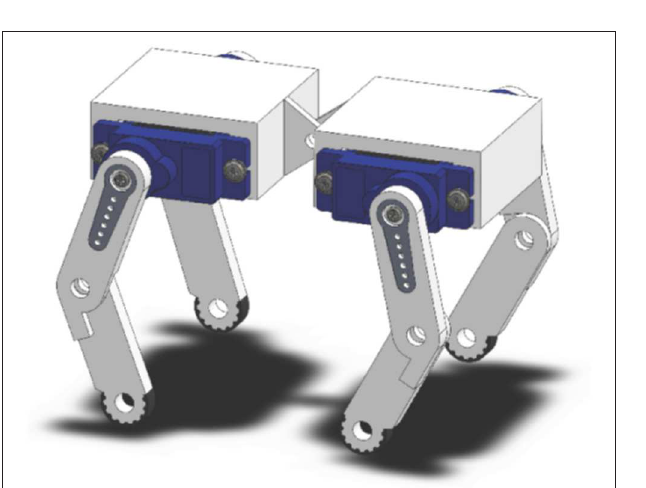
FIGURE 4 | First SG90 servomotor used in our